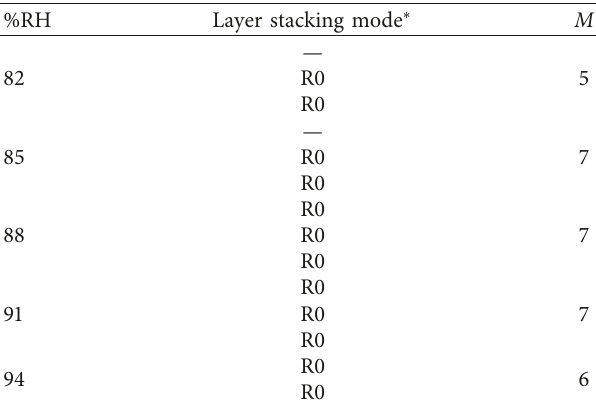
Note: 3W, 2W, 1W, and 0W are attributed to the layer hydration state. n H the number of H 2 O molecules per half unit cell is fixed to 2.5, 5.6, and 6.1, respectively, for 1W, 2W, and 3W. Z Na : the position of exchangeable cations per half unit cell calculated along the c ∗ axis is fixed to 8.30 ˚A, 9.50 ˚A, 11.25 ˚A, and 12.60 ˚A, respectively, for 0W, 1W, 2W, and 3W hydration state. n minerals. ∗ R , Reichweite factor; R0 and R1 describe the MLS with random interstratifications or with partial segregation; M : the average number of layers per particle; P AA : layer succession